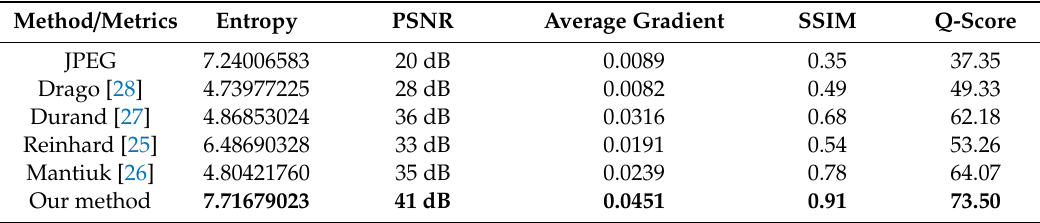
Table 2. The analysis of the experimental comparative.